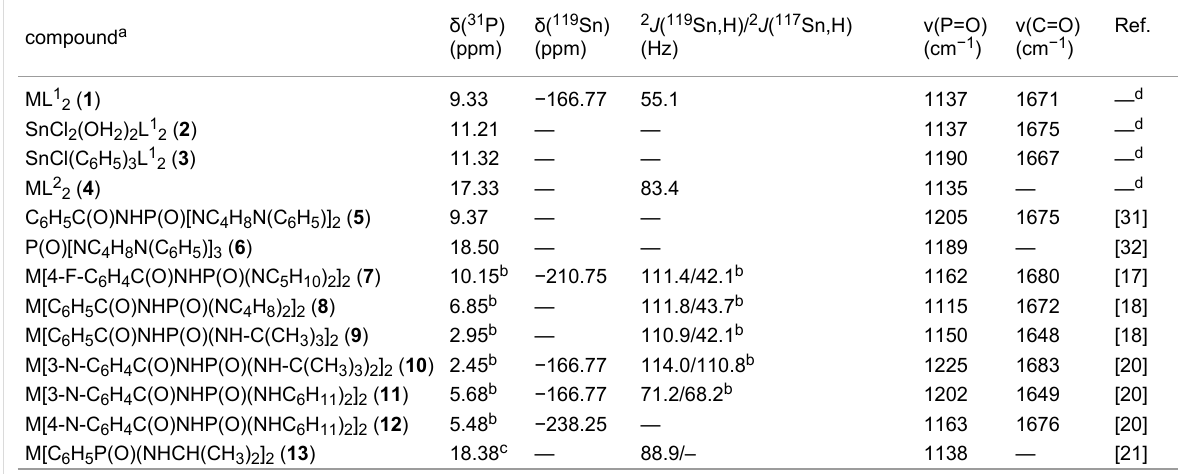
Table 1: Selected spectroscopic NMR and IR data of compounds 1 – 13 .